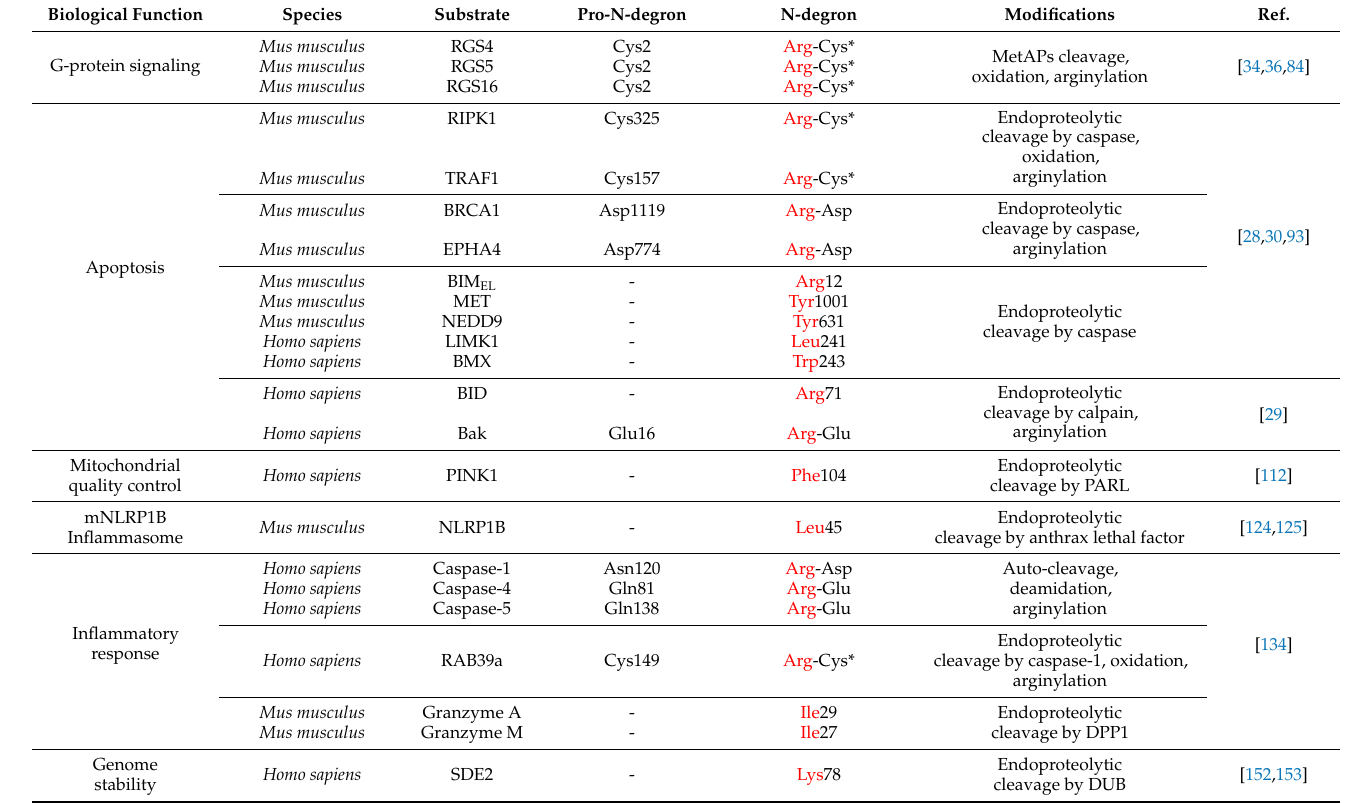
Table 1. Physiological N-degron substrates of the Arg/N-degron